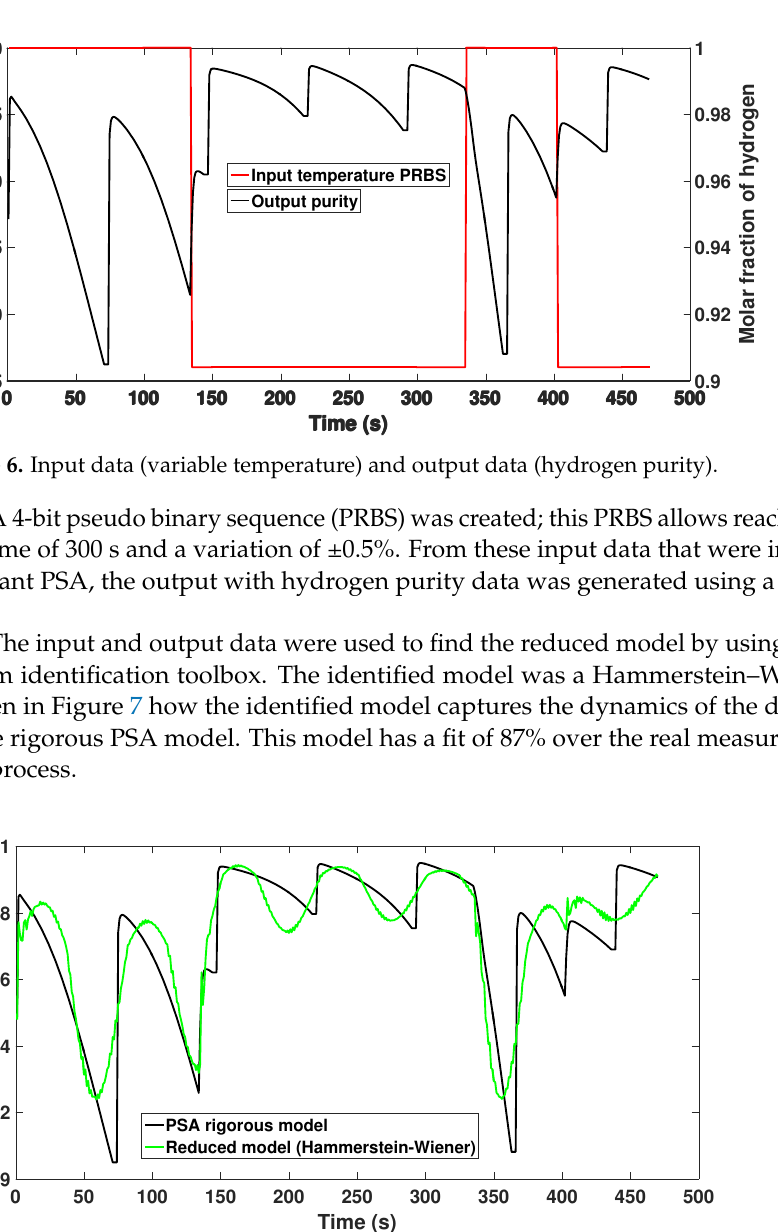
Figure 7. Comparative results between the Hammerstein–Wiener model and the rigorous PSA model.